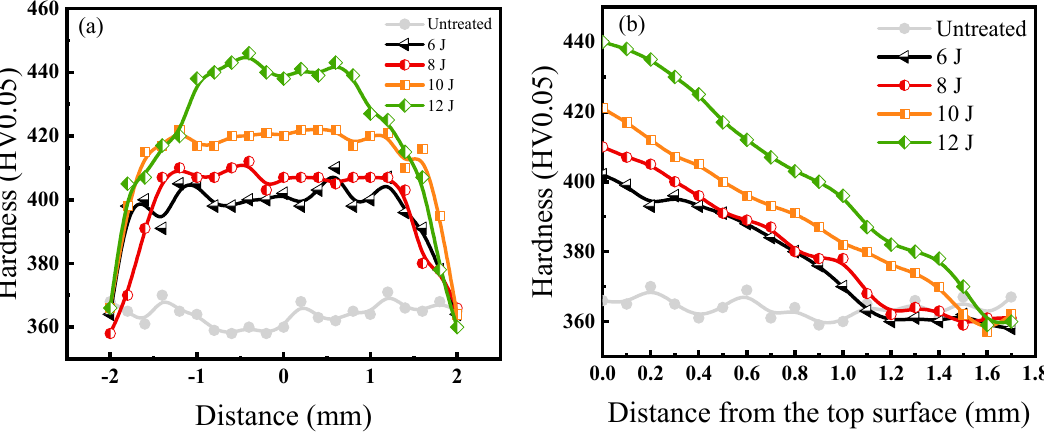
Figure 10. Microhardness at different pulse energies ( a ) Surface microhardness ( b ) Microhardness in the cross-sectional direction.